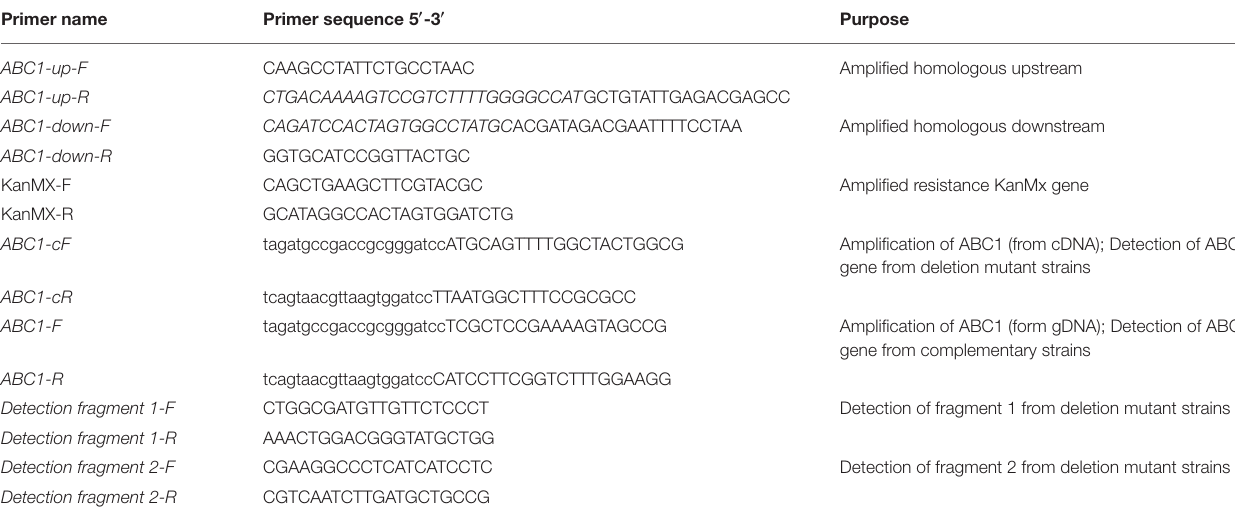
TABLE 2 | ABC1 Gene knockout and complement experiment primers.